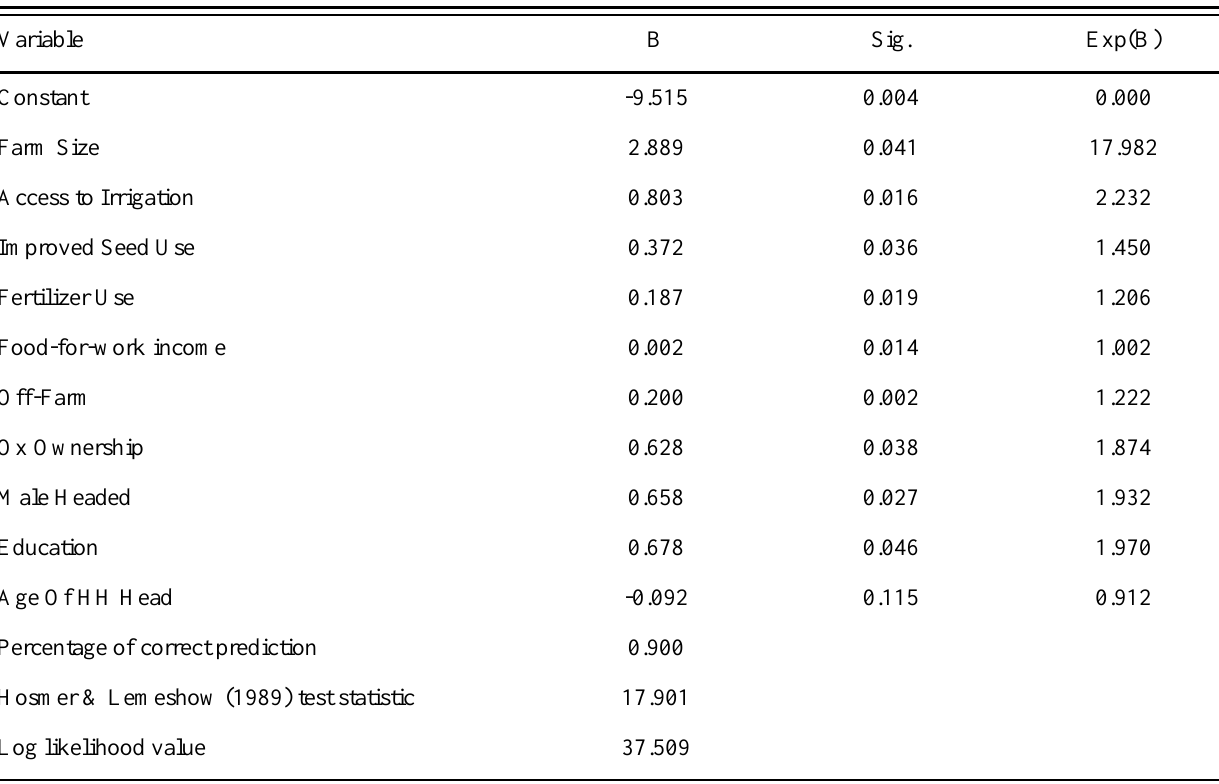
Table 3 . Logit estimation on the likelihood of household food security